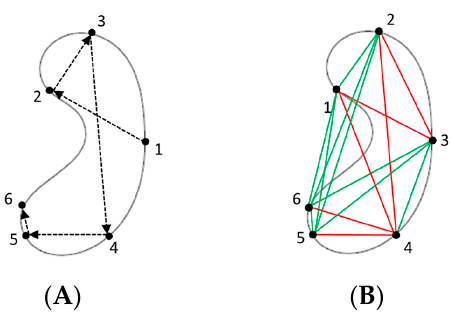
Figure 1. Dynamic billiard as the Ramsey system. ( A ) Trajectory of the point within the pool (billiard) is shown with violet arrows. ( B ) Complete graph arising from six points, depicting reflections from the